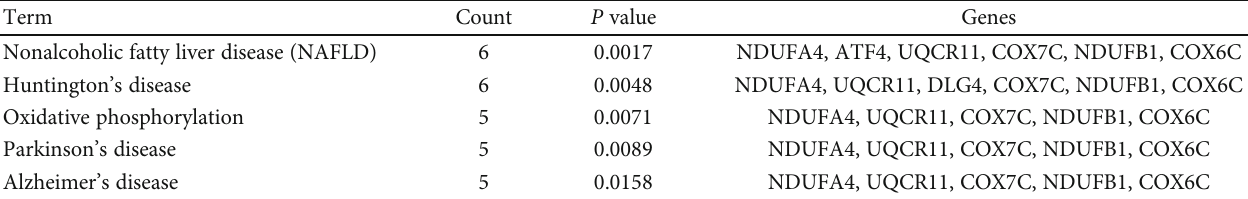
Table 2: The results of Kyoto Encyclopedia of Genes and Genomes (KEGG) of DEGs ranked by P